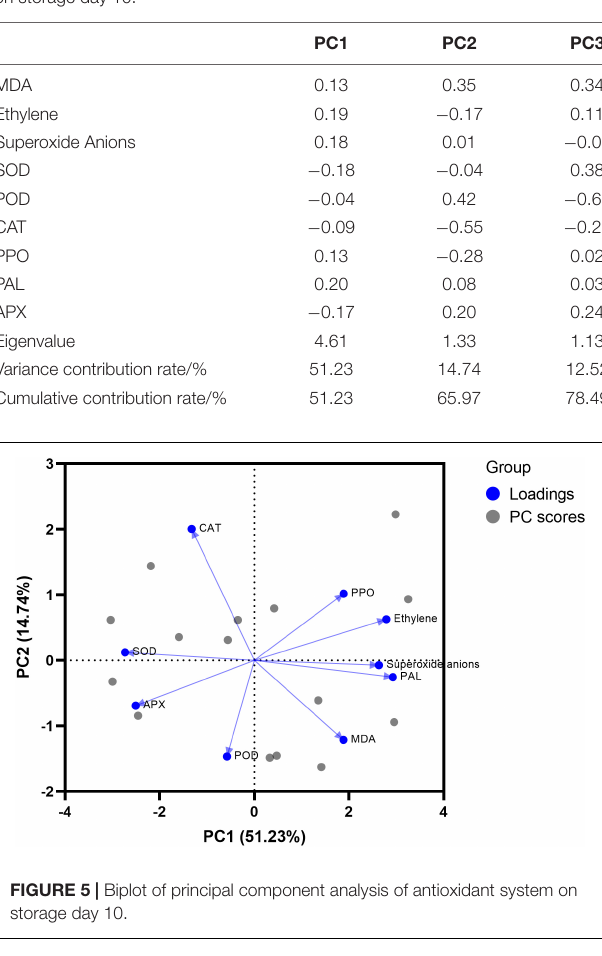
papaya fruit firmness by suppressing the activities of pectic enzymes and cellulases like PG and β -glucosidase ( β -Glu). However, the higher concentration of treatment (treatment D) affected the effect of storage. Vilar et al. (2019) concluded that 3, 5, and 7% (v/v) ethanol in combination with hydrothermal treatment shortened the shelf life of mangoes for ripening faster and were not recommended for export. We speculated that, in order to convert high concentrations of ethanol into acetaldehyde and ethyl acetate, pulp cells accelerated the anaerobic respiration rate and storage energy consumption, which affects the storage